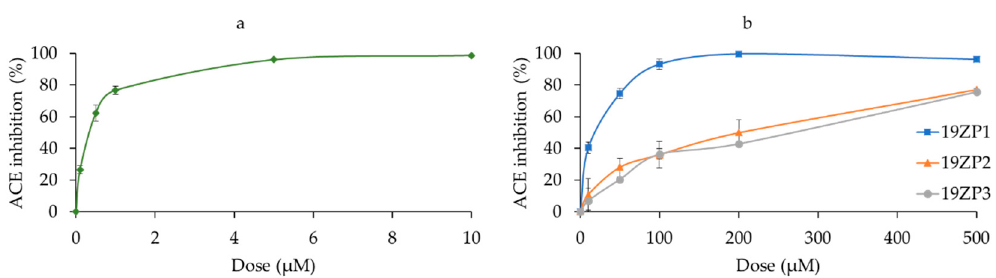
Figure 7. In vitro ACE inhibitory activity of peptides ( b ) compared to the positive control captopril ( a ). Dose-response curves were calculated using enzymatic activity values from the kinetic assay by reading fluorescence intensity (excitation 320 nm/emission 405 nm) every minute for 5 min for each dose. Results are expressed as values ± standard deviation; n = 2. Superscript letters represent statistical differences among samples. Statistical difference was determined by Tukey’s test ( p < 0.05).